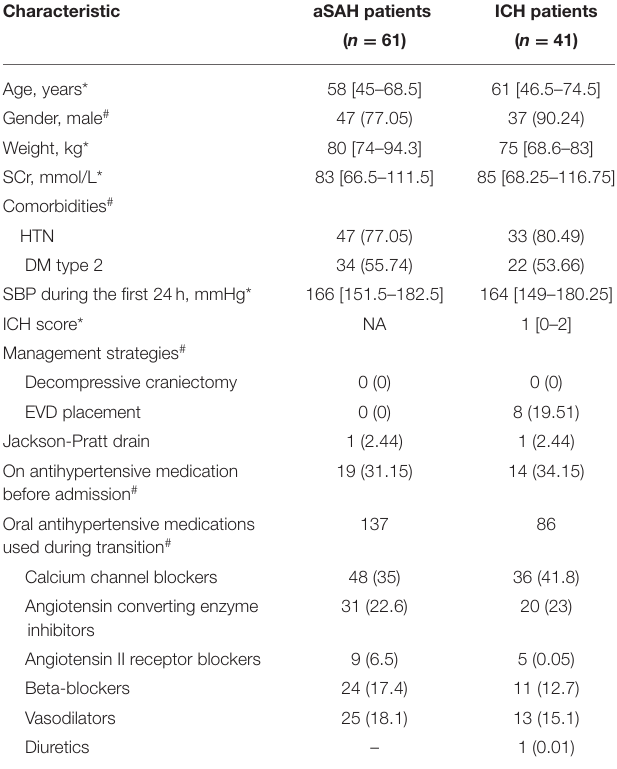
TABLE 1 | Baseline